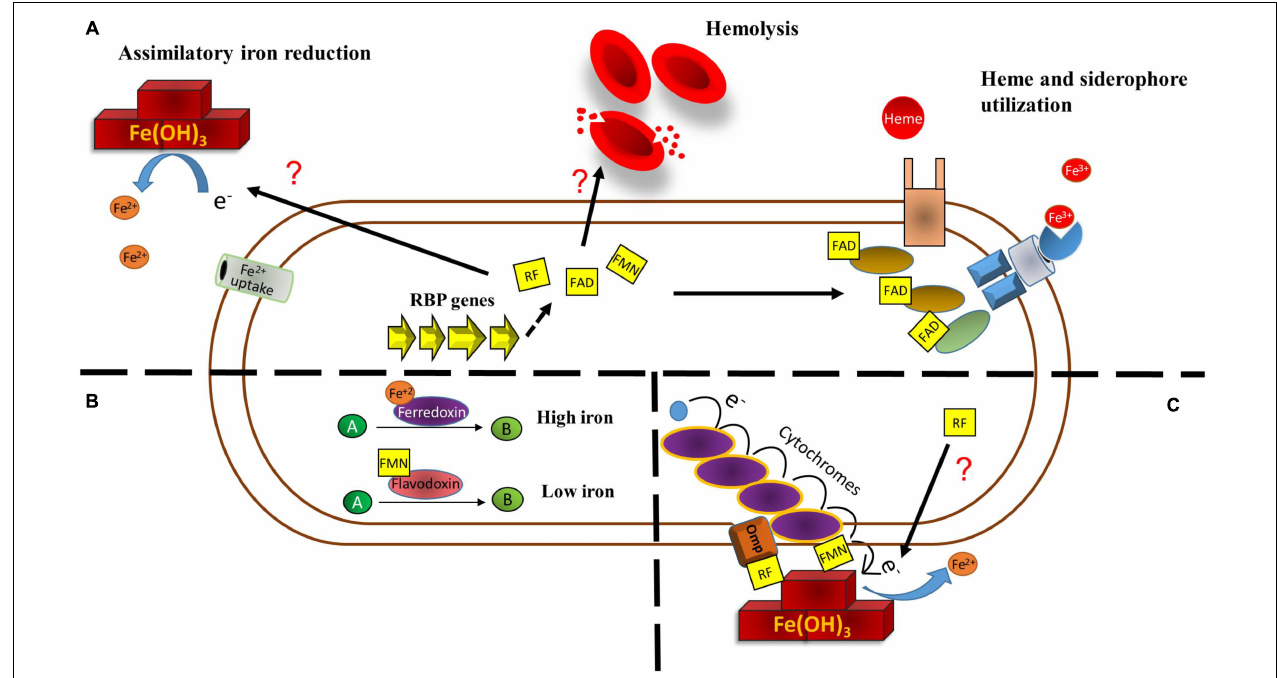
FIGURE 1 | Main direct metabolic relationships among riboflavin and iron in bacteria. (A) Riboflavin may help overcome iron restriction status in three principal ways. Riboflavin increases extracellular iron reduction by a yet uncharacterized mechanism. This increases iron solubility and could make it prone to uptake by ferrous iron uptake systems. Increases in bacterial riboflavin expression produce a higher degree of hemolysis, which can increase hemoglobin availability. Also, flavins function as cofactor for enzymes involved in heme utilization and iron release from siderophores. (B) Under iron restriction, enzymes using iron as redox cofactor to catalyze a reaction may be replaced by enzymes that use flavins as cofactor. (C) Riboflavin increases dissimilatory ferric reduction. In S. oneidensis , extracellular ferric iron is used as final electron acceptor to complete the electron transport chain from quinol. This is achieved by a set of cytochromes and an outer membrane protein with the aid of flavins. In other bacteria, the mechanism has not been